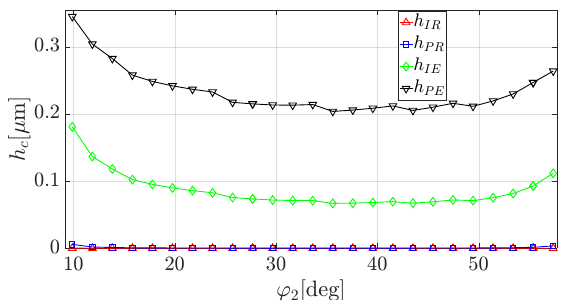
Figure 5. Central film thickness ( h c ) values over a mesh cycle.